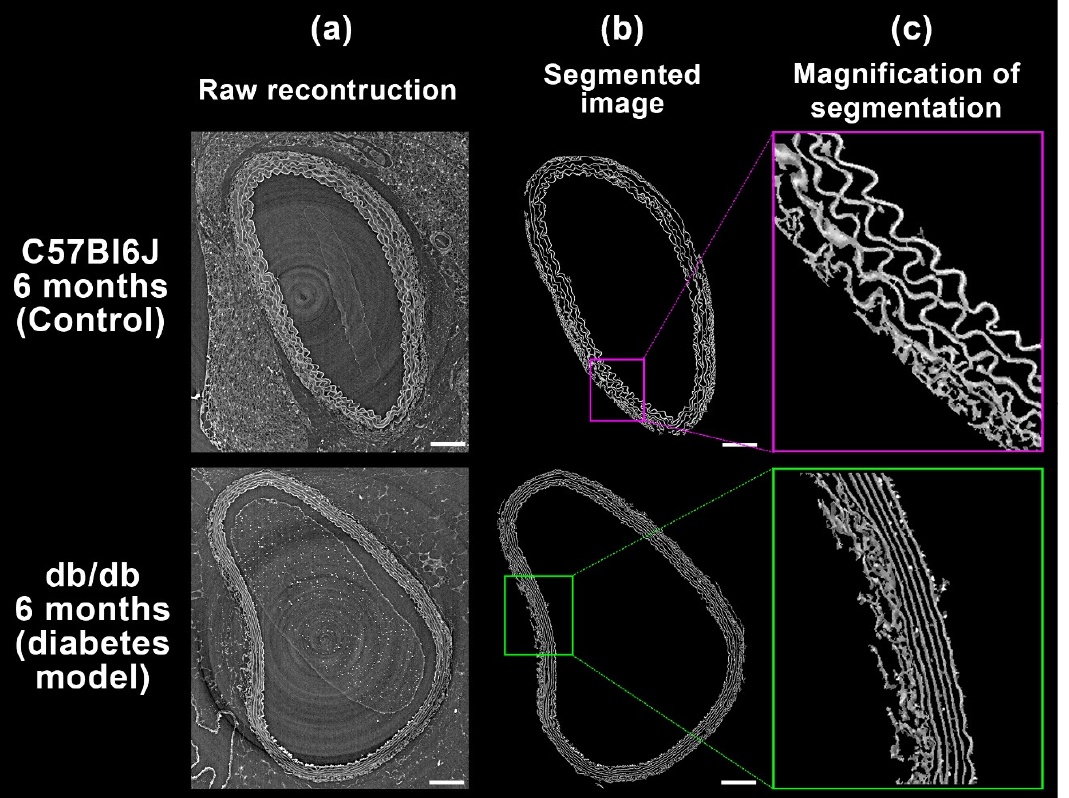
Figure 2. Effect of diabetes on the aortic structure of the mouse arterial wall. Typical result of synchrotron X-ray microtomography acquisition (650 nm/voxel) with in-line phase-contrast of a paraffin-embedded 6-month mouse aorta segment. Raw reconstruction ( a ) and segmented image ( b ) are shown. Control mouse (upper images row) and diabetes mouse models (lower images row) exhibit significant differences in the appearance of their elastic lamellae as shown by enlarged details ( c ) respectively framed in purple and green, that reveal wavy lamella structures for the control specimen and smooth ones for the diabetic mouse. Scale bars = 100 µm.